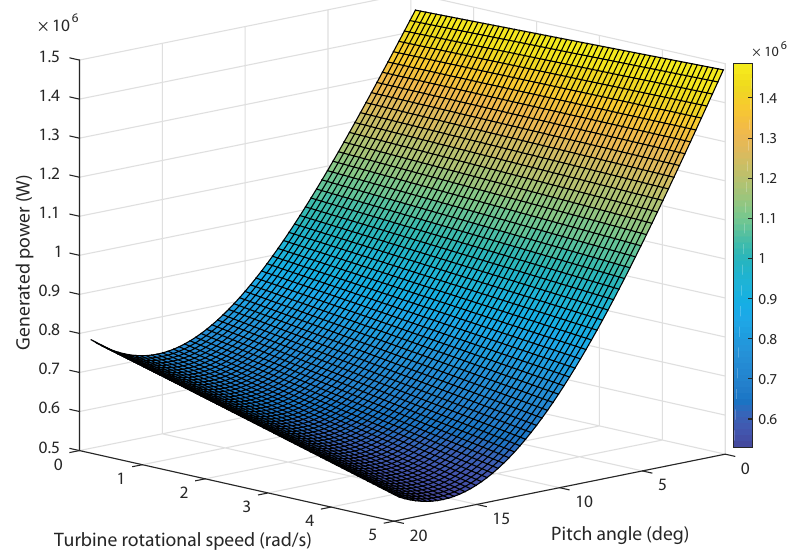
Figure 5. Generated power versus rotational speed for different pitch angles at rated tidal